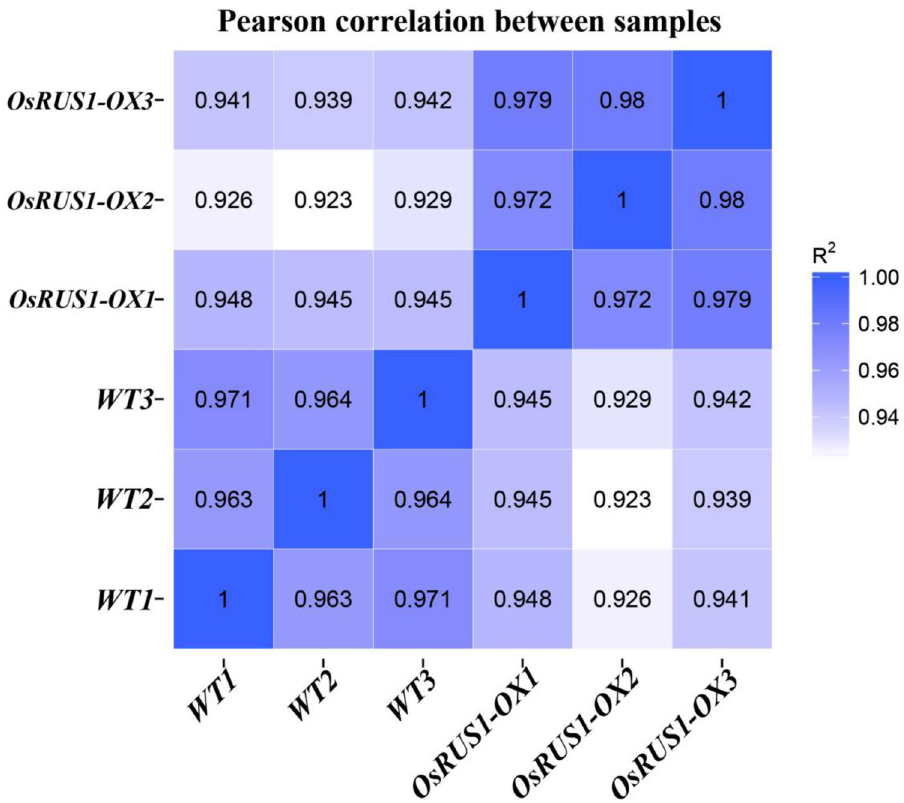
Figure 2. Pearson correlation between WT and OsRUS1-OX RNA-Seq data.The change of the square (R 2 ) value of the correlation coefficient of Pearson is indicated by the change of the blue color. The deeper color indicates a bigger R 2 value and a higher correlation between samples. WT, the wildtype of ZhongHua11; OsRUS1-OX , the OsRUS1-GFP Overexpression transgenic